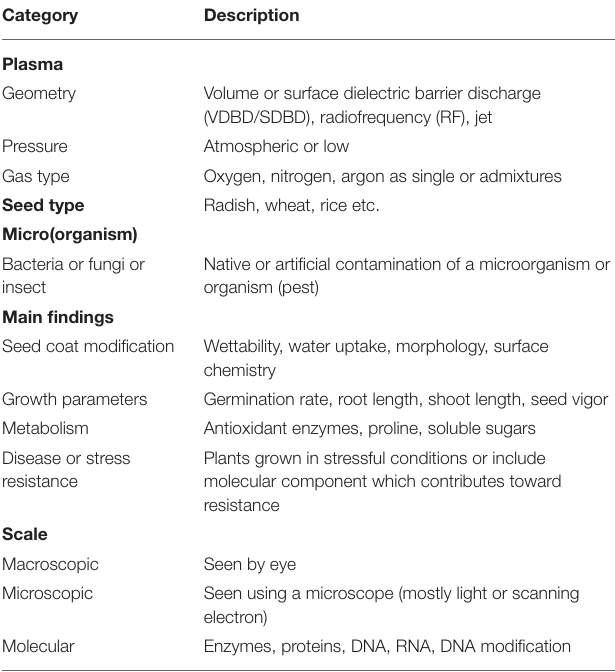
TABLE 1 | Legend describing each category of Table 2 for the type of plasma and seed used in the study as well as the main findings (see this table for a description of the